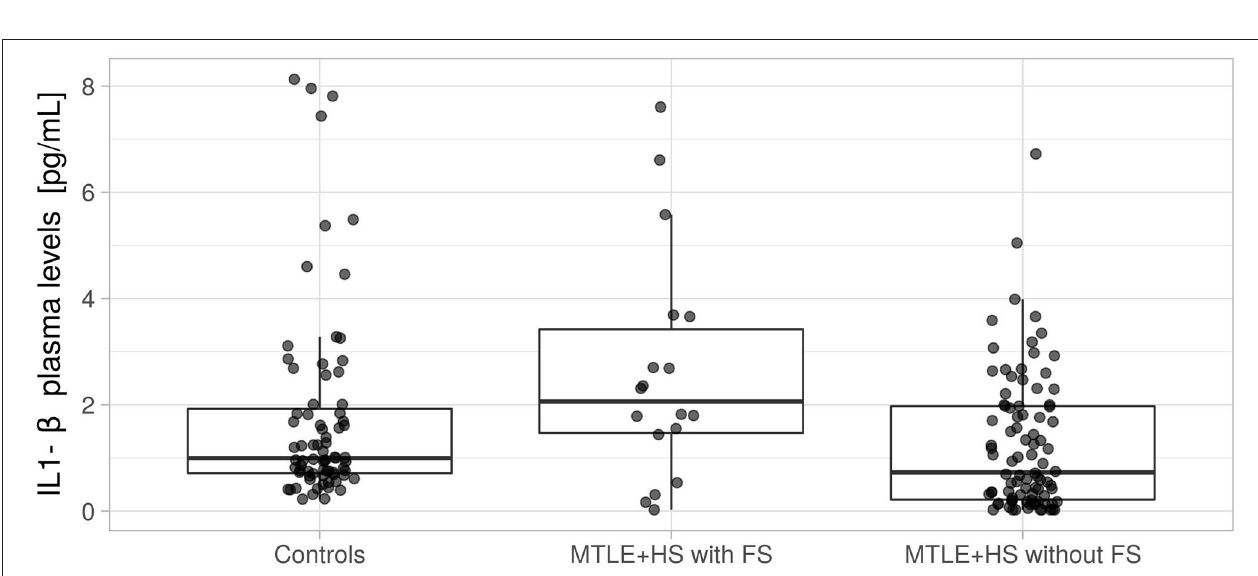
FIGURE 1 | Relative quantification of the IL1B (interleukin 1 beta) transcript in the hippocampal tissue of four patients with pharmacoresistant mesial temporal lobe epilepsy, who were operated on to control refractory seizures, and autopsy controls ( n = 6). (A) Analysis performed using the SYP (synaptophysin) gene as an endogenous control (Wilcoxon rank-sum test, adjusted p = 0.0762). (B) Analysis performed using the SDHA (succinate dehydrogenase, subunit A) gene as an endogenous control (Wilcoxon rank-sum test, adjusted p = 0.1334).